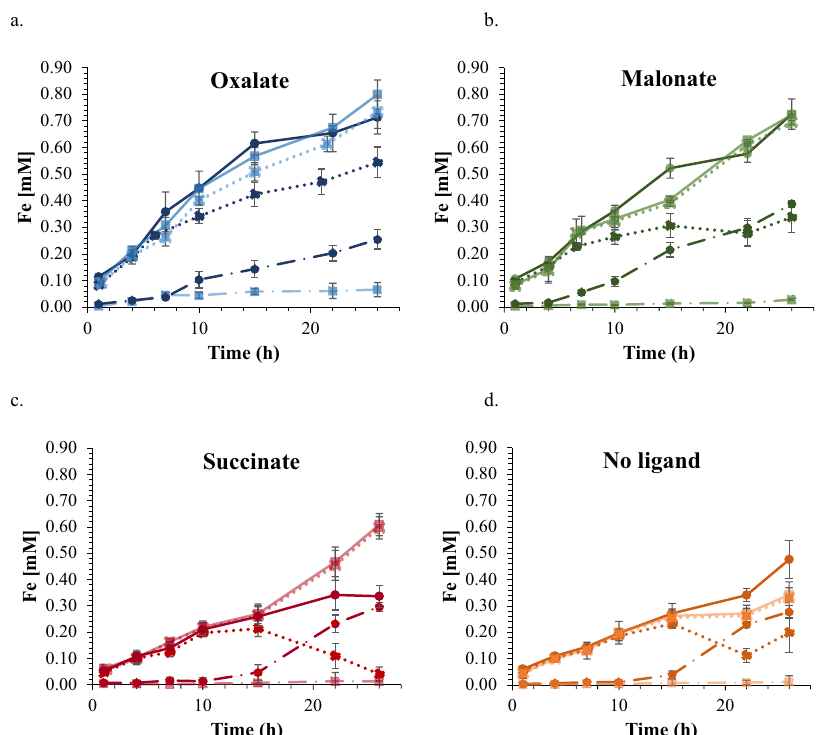
Fig. 2 Time course of iron speciation in experiments with oxidized carbon steel and 50 mM dicarboxylates. Panels show the iron speciation for the experiments with a ) oxalate, b ) malonate, c ) succinate, and d ) no ligand. Pale color squares represent abiotic experiments whereas dark color circles represent biotic experiments. The solid lines ( – ) denote total dissolved iron concentration, whereas dashed lines denote Fe(II) ( – · ) and Fe (III) ( ···· ). Error bars represent standard deviations of triplicate measurements. Experiments were carried out under anoxic and dark conditions, at circumneutral pH, and 30